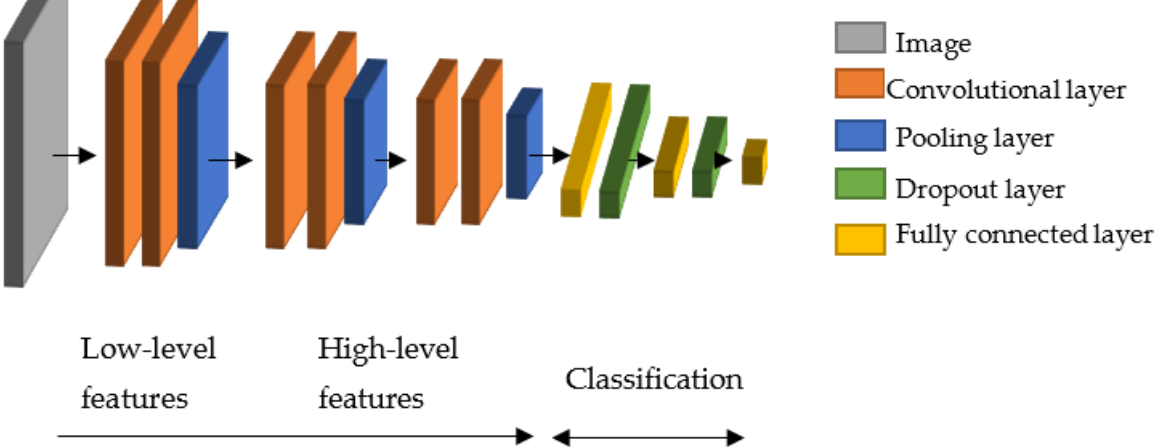
Figure 6. Different tasks of the parts of the presented CNN. They start with low-level feature extraction and end with classification with the help of fully connected layers.